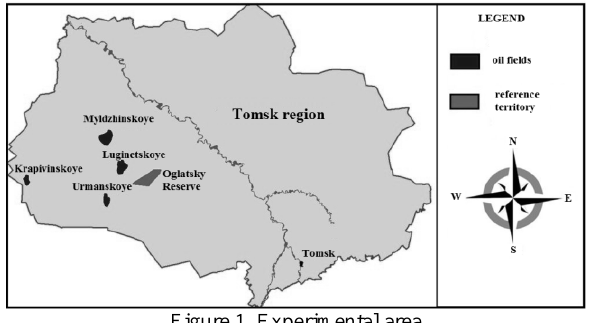
Figure 1. Experimental area